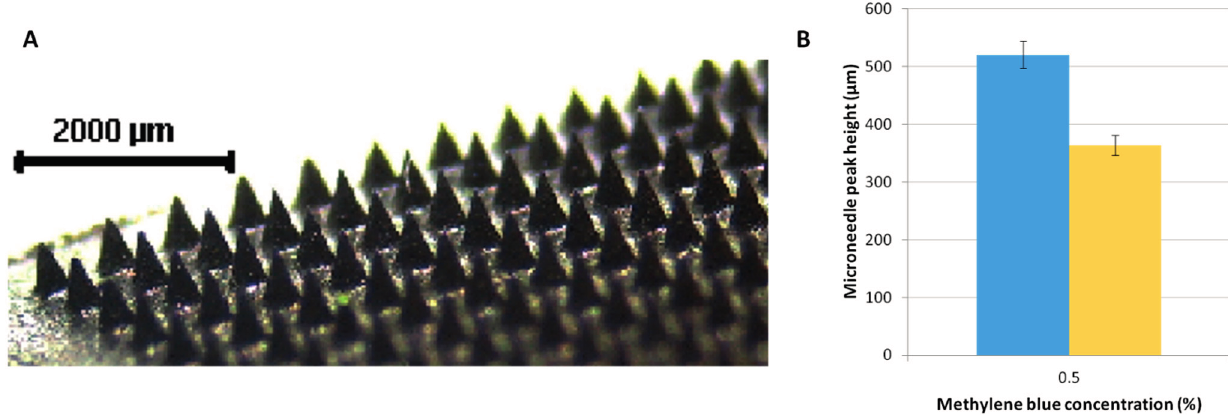
Figure 2. ( A ) Digital image of the methylene blue-loaded microneedle (MN). ( B ) Average microneedle peak heights before and after compression with a 70.56 N force applied to the array (Means ± S.D., n =